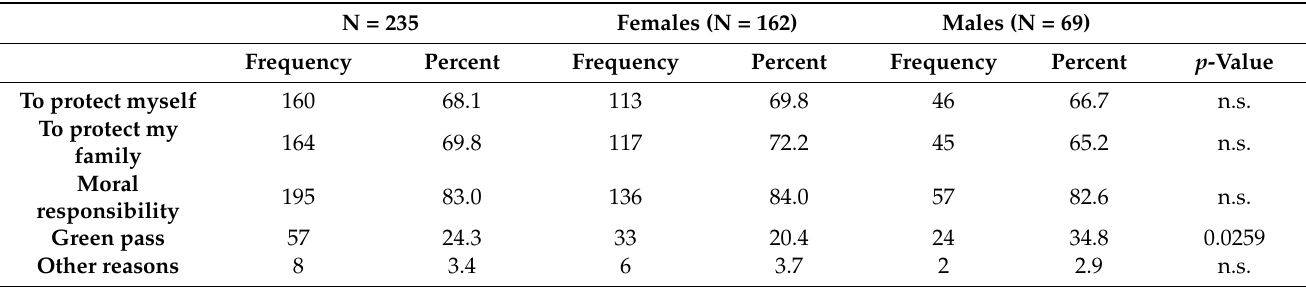
Table 2. Reasons why the students were vaccinated.